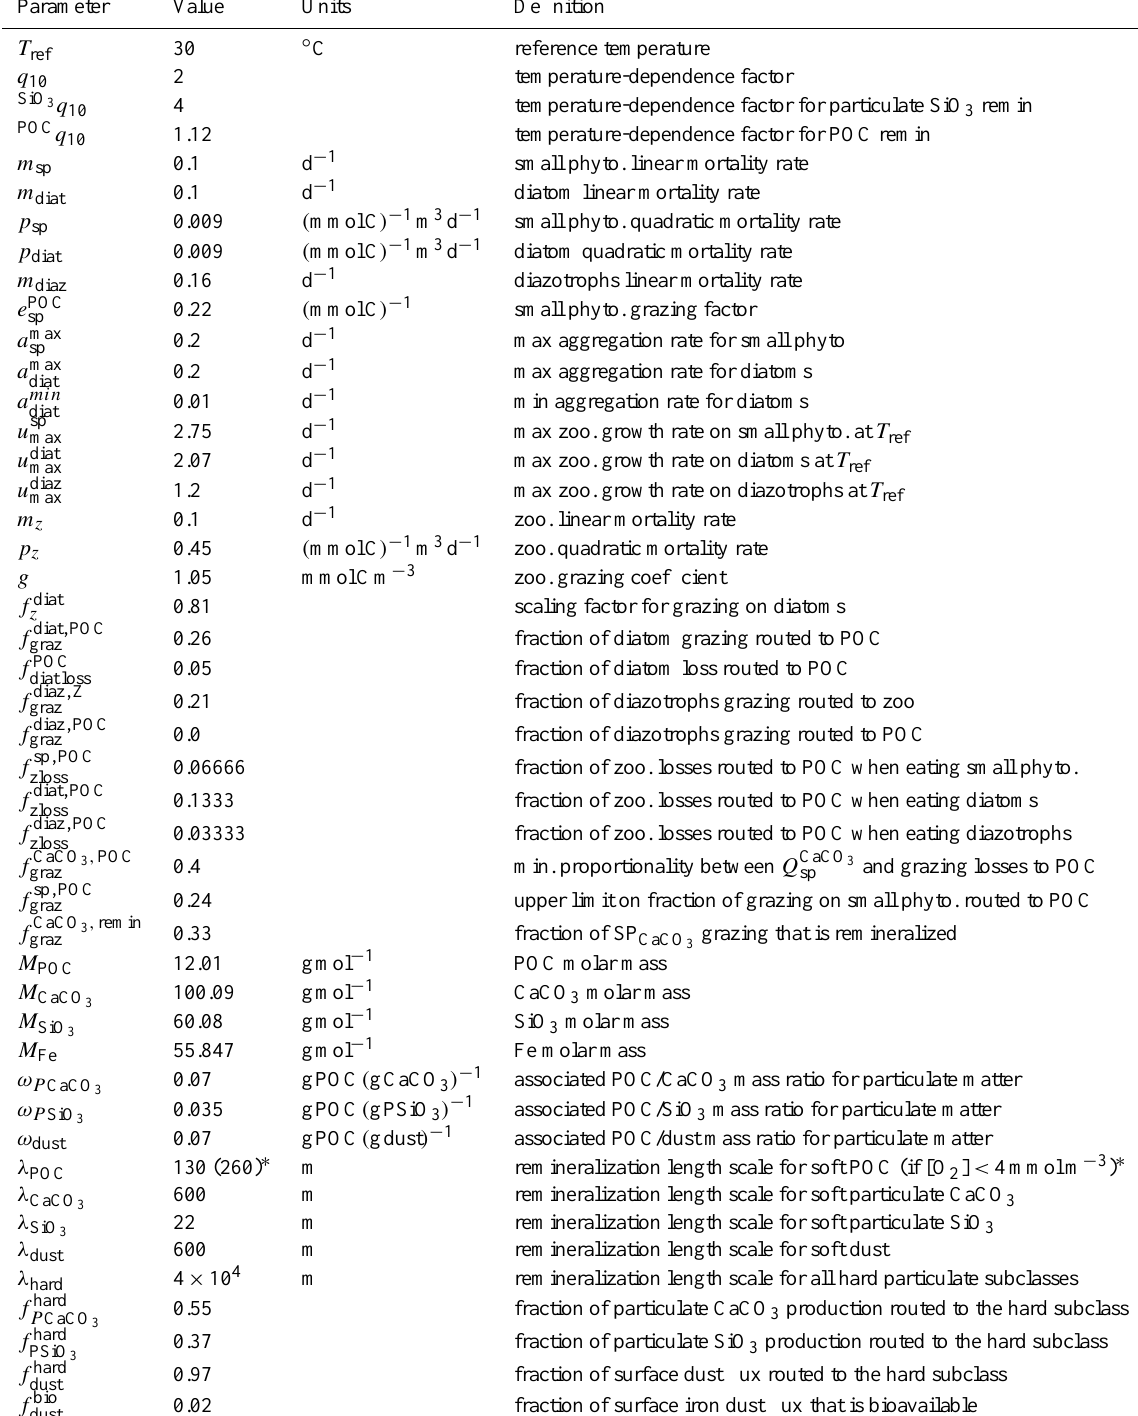
Table 7. Equation parameters’ definitions and